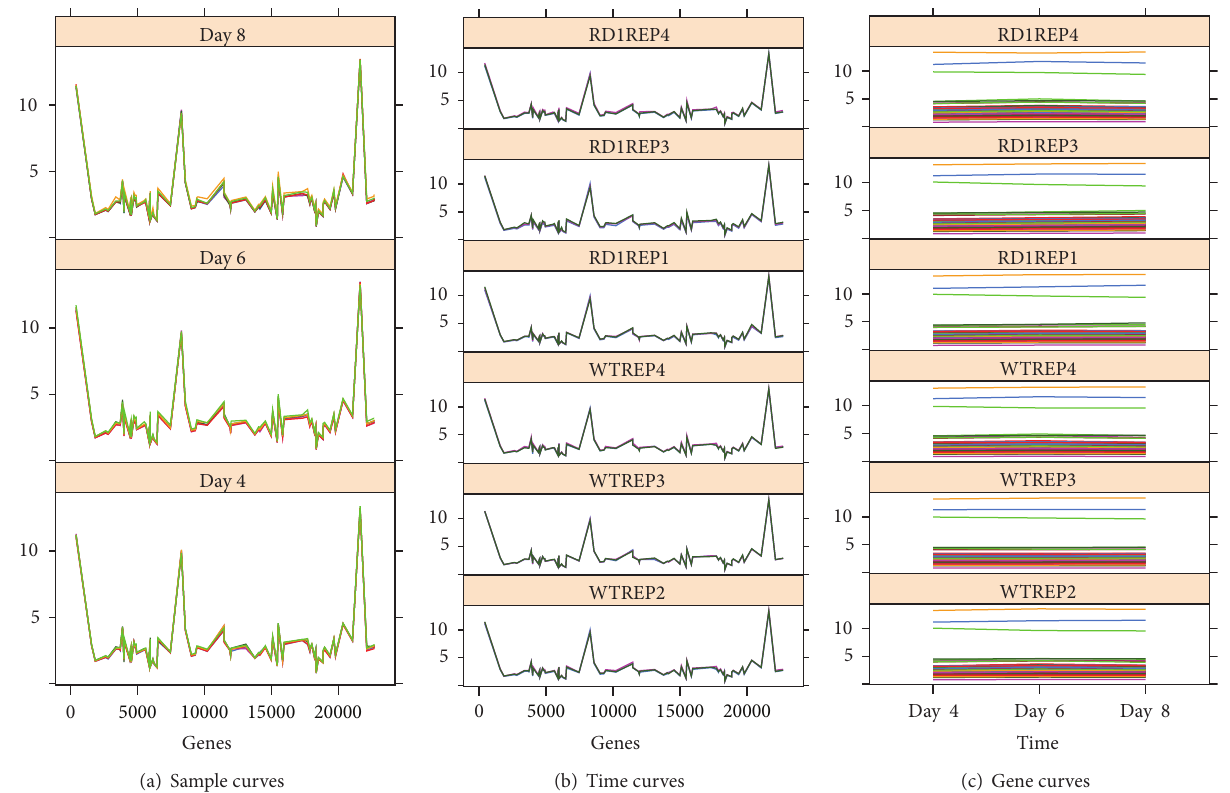
Figure 8: Graphical representation for tricluster TC 20 found in the Mouse GSD4510 Dataset.